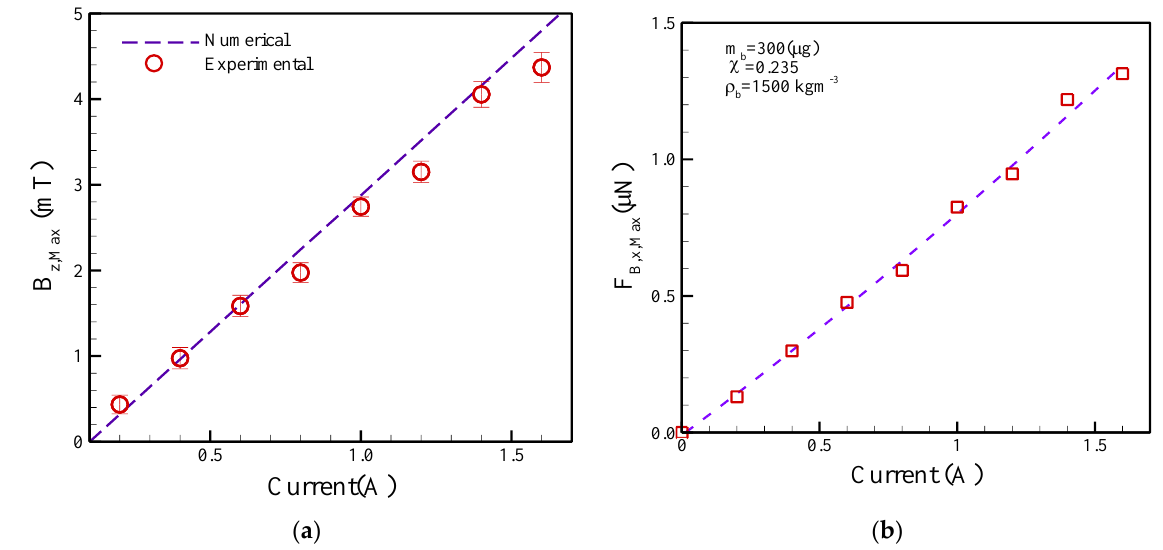
Figure 6. ( a ) Numerical and experimental results of B Z,Max and ( b ) calculations of F B,X,Max versus different DC currents.